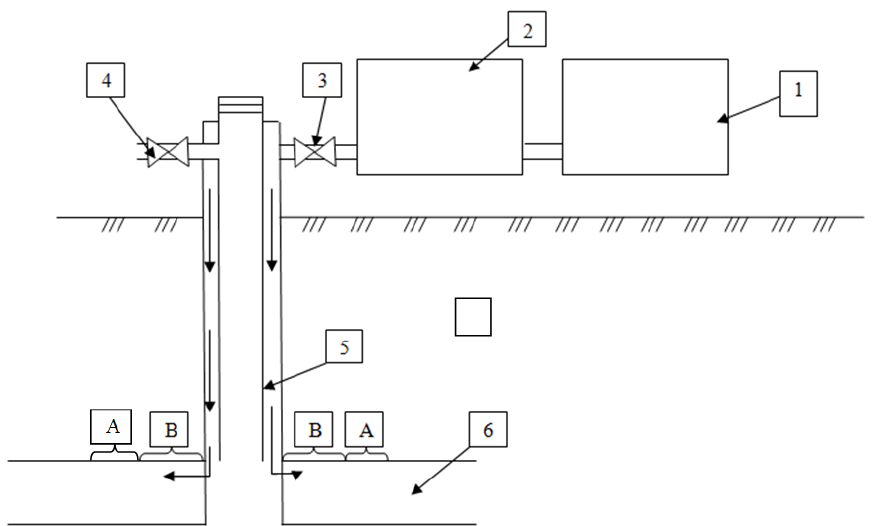
Figure 2. Technological scheme for preventing the formation of deposits via injection of an ARPD inhibitor into the BHFZ. 1 — a tank truck with an ARPD inhibitor solution; 2 — a pumping unit; 3 — an annular valve; 4 — a valve; 5 — a tubing; 6 — a producing formation; A — the zone of penetration of the ARPD inhibitor; B — the zone of penetration of displacement fluid.